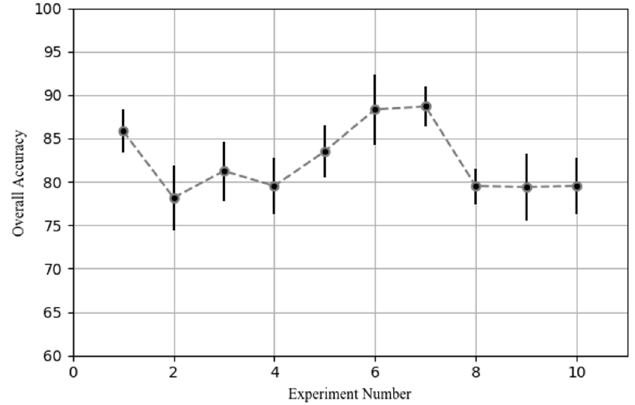
Figure 8. Overall accuracy variation changes with parameters w (representing the size of the local window where a dark pixel exists) and P (defining the maximum acceptable gray level required by a pixel to become a dark pixel).